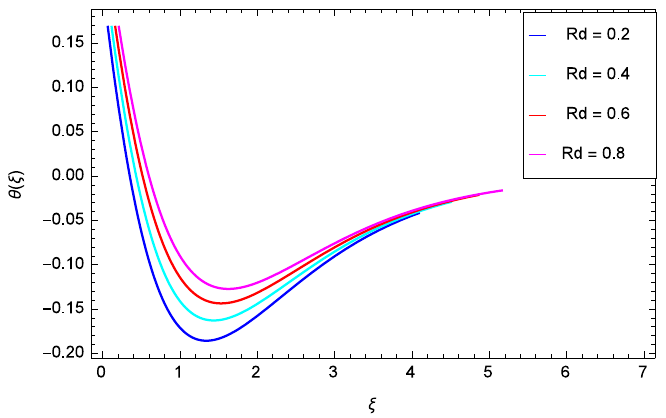
Figure 15. Impact of the thermal radiation parameter Rd on temperature θ ( ζ ) .